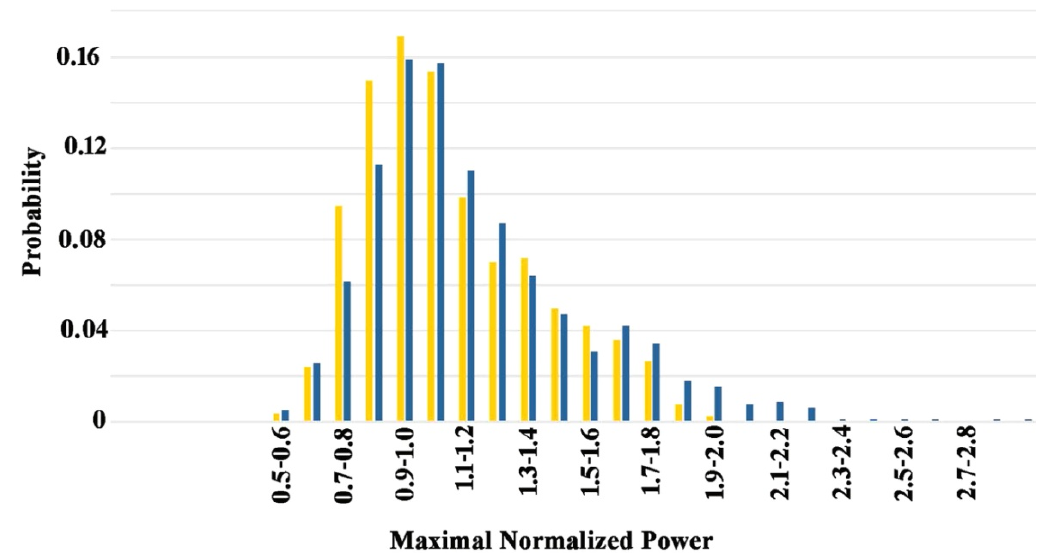
Figure 9. Probability for sand (yellow) or sandstone (blue) for a given range of maximal normalized power.